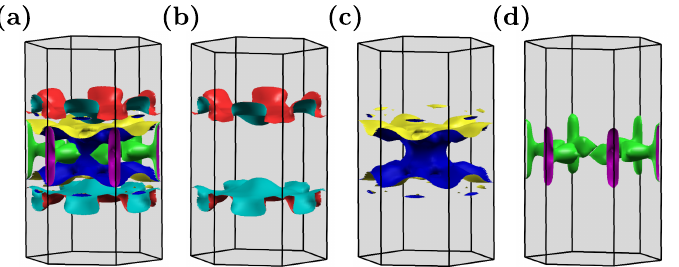
Figure 7. The Fermi surface for the P¯62m symmetry (in the absence of spin–orbit coupling). Panel ( a ) presents the total Fermi surface, while panels ( b – d ) show separated